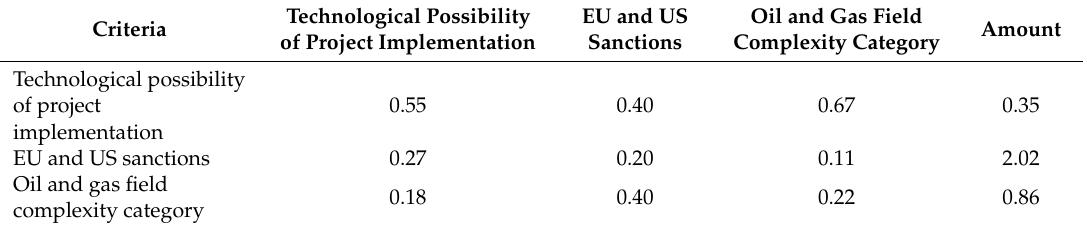
Table A8. Results of a normalized assessment of the relative importance of technological sustainability criteria.